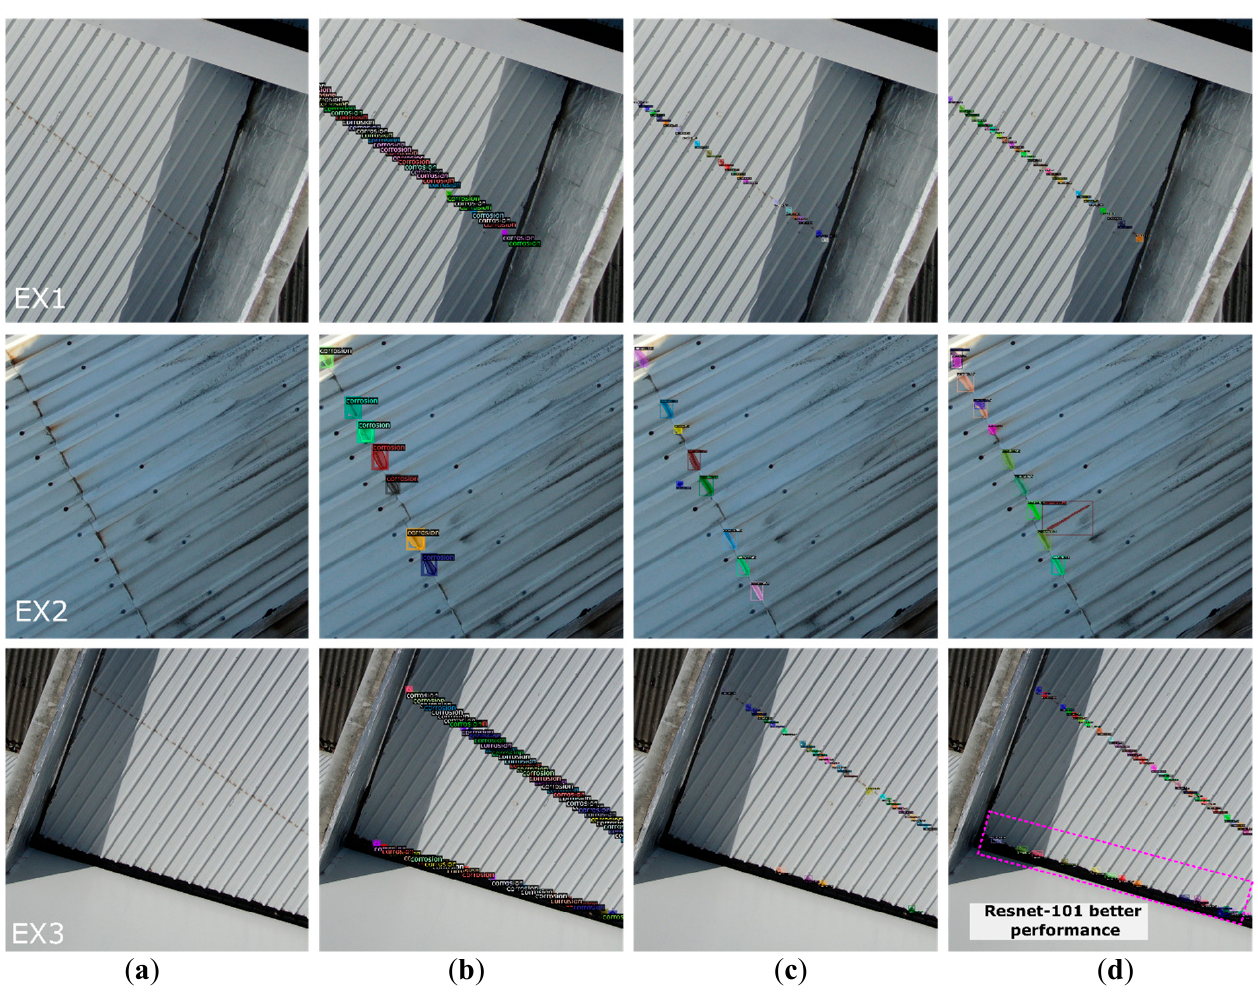
Figure 15. Evaluation of the influence of the backbone network on the efficiency of image classification based on different examples (EX1 to EX3): ( a ) original images, ( b ) ground truth, ( c ) Resnet-50, and ( d ) Resnet-101.